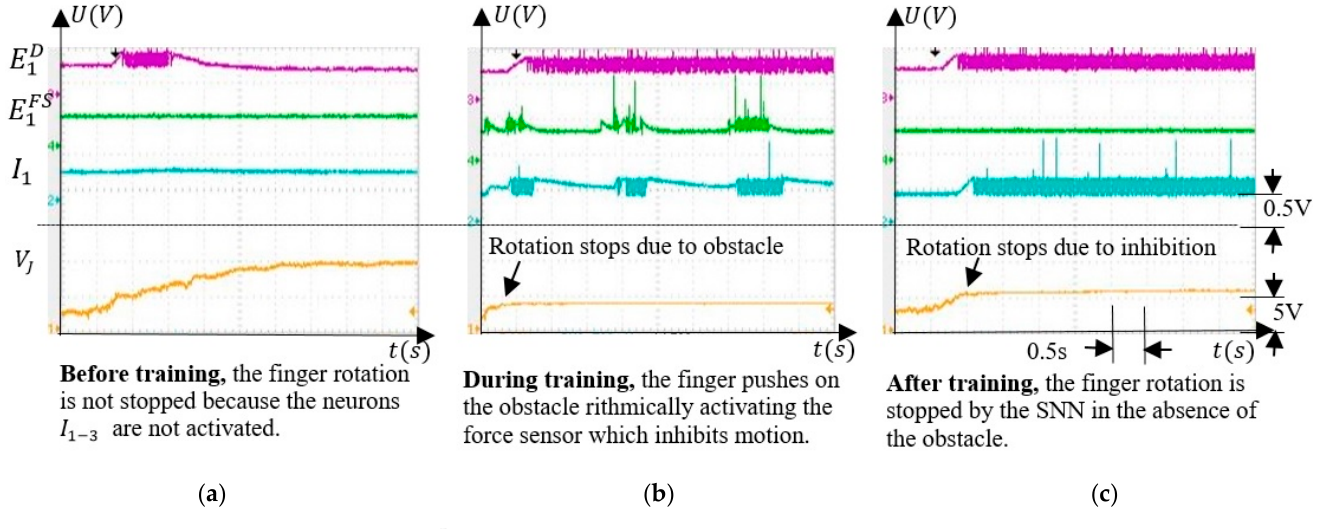
Figure 9. ( a ) Before training, neuron E D detects the presence of the finger in the corresponding angle interval; ( b ) during training, neuron E D is activated simultaneously with the neuron E FS activating the neuron I 1 ; ( c ) after training, neuron E D activates inhibitory neuron I 1 stopping the finger rotation without the activity of the E FS